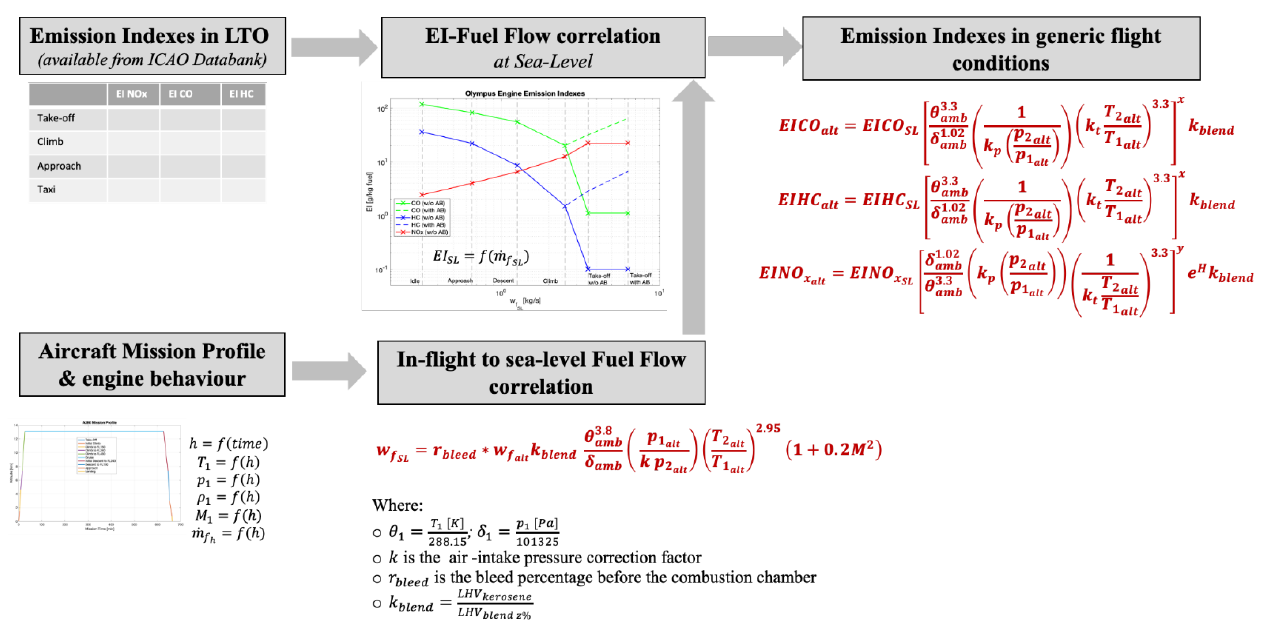
Figure 4. Sustainable supersonic fuel flow method (S2F2) to cope with supersonic case studies and sustainable aviation fuels.